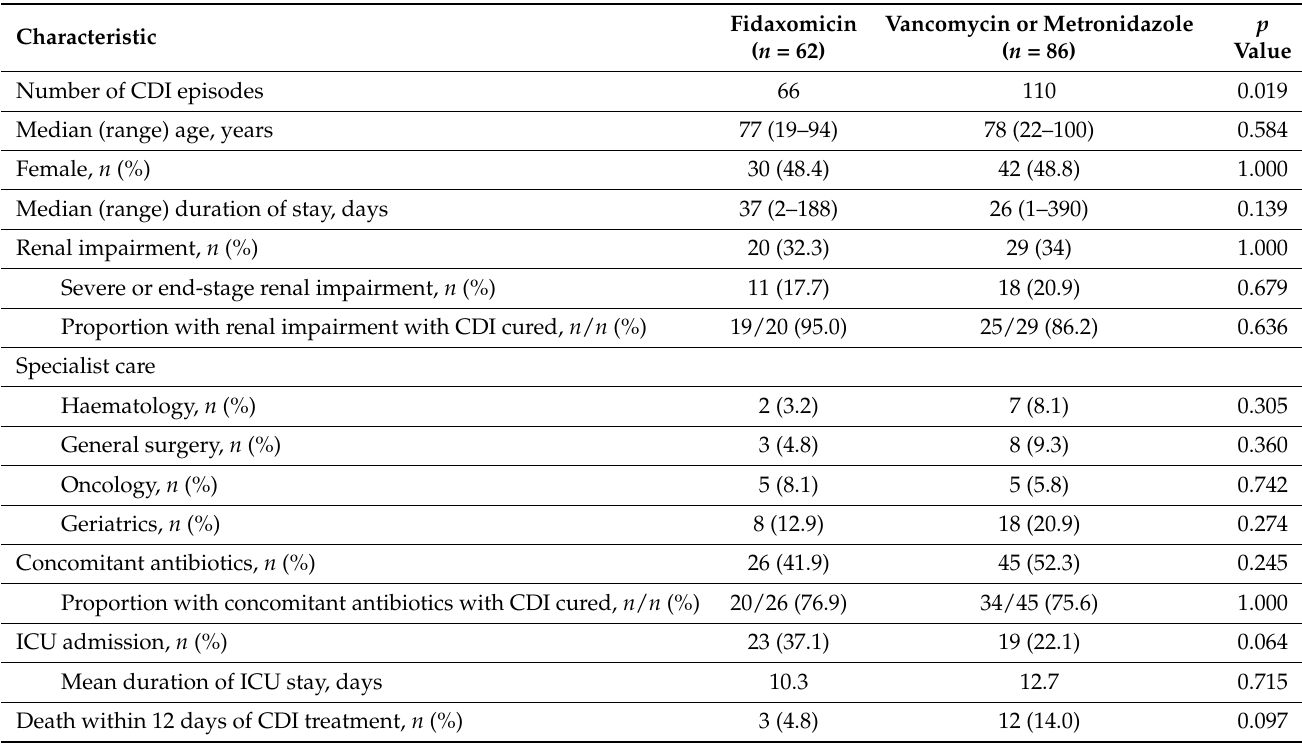
Table 1. Patient demographics and clinical characteristics.